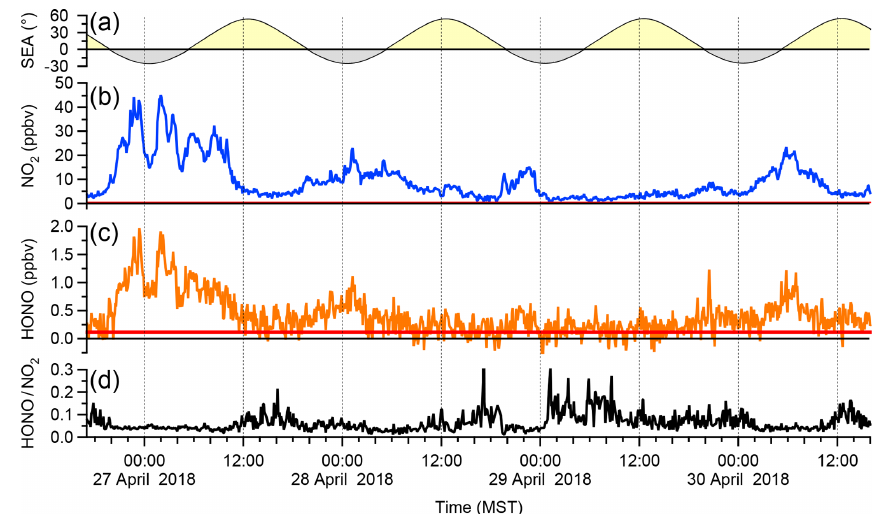
Figure 7. Sample ambient air data. (a) Solar elevation angle (SEA) with the yellow and grey shading symbolizing night and day. (b) IB- BCEAS NO 2 mixing ratios (c) IBBCEAS HONO mixing ratios. The red solid lines indicate the IBBCEAS LOD (2 σ level). (d) HONO : NO 2 ratio calculated from the above. Points below the LOD of HONO were removed from panel (d) prior to